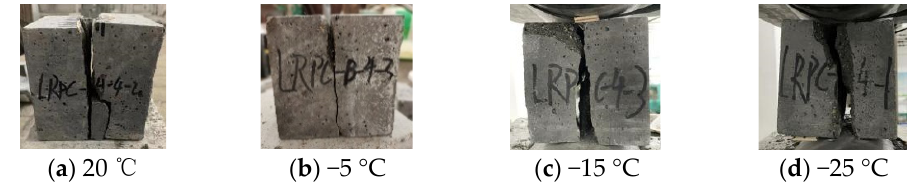
Figure 14. Splitting tensile failure modes of CFRPC3 cubic specimens after different exposure tem- peratures.